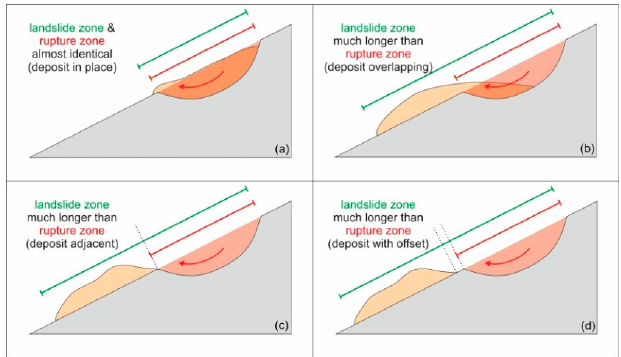
Figure 1. Comparison (identical ( a ), overlap ( b ), adjacent ( c ), and offset ( d )) of rupture zones and landslide zones (i.e., entire zones affected by sliding processes, which are mainly dependent on the location of the landslide deposits).